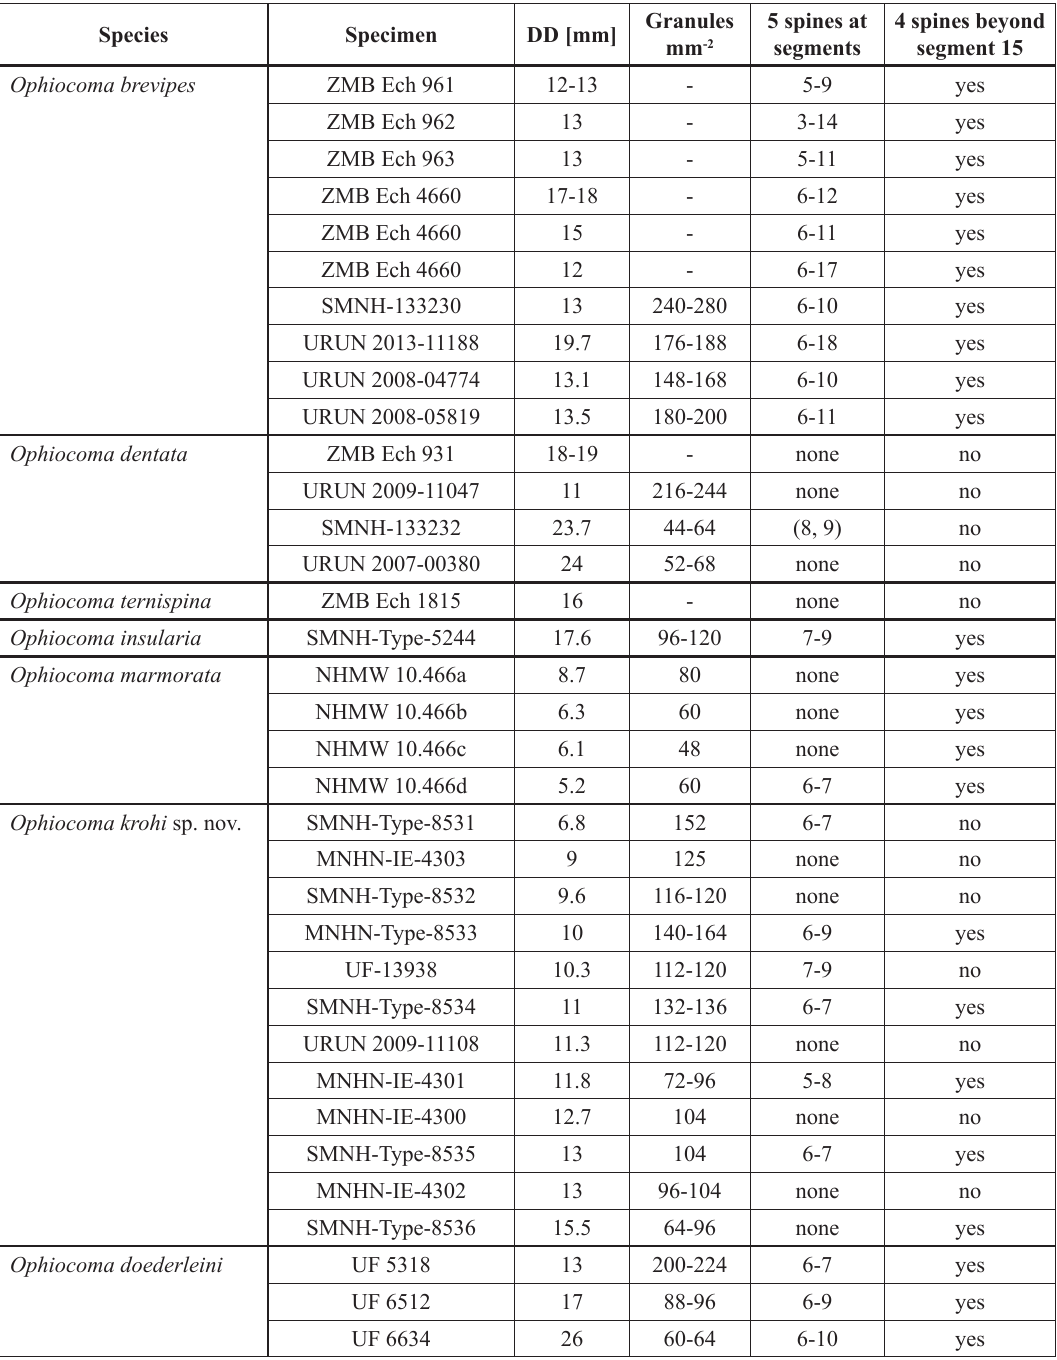
Table 1. Morphometric data for the species of Ophiocoma ( Breviturma ) subgen. nov. Type material from Zoological Museum Berlin (ZMB), Swedish Museum of Natural History (SMNH) and Natural History Museum Vienna (NHMW). Specimen NHMW 104.66a is regarded as the holotype of O. marmorata , the other specimens of that lot most likely belong to a different species. DD, disc diameter, MNHN, Muséum national d’Histoire naturelle (Paris), UF, Florida Museum of Natural History, URUN, University of La